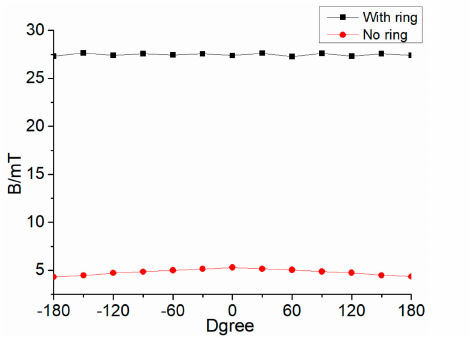
Figure 12. Magnetic flux density of the Hall component with di ff erent